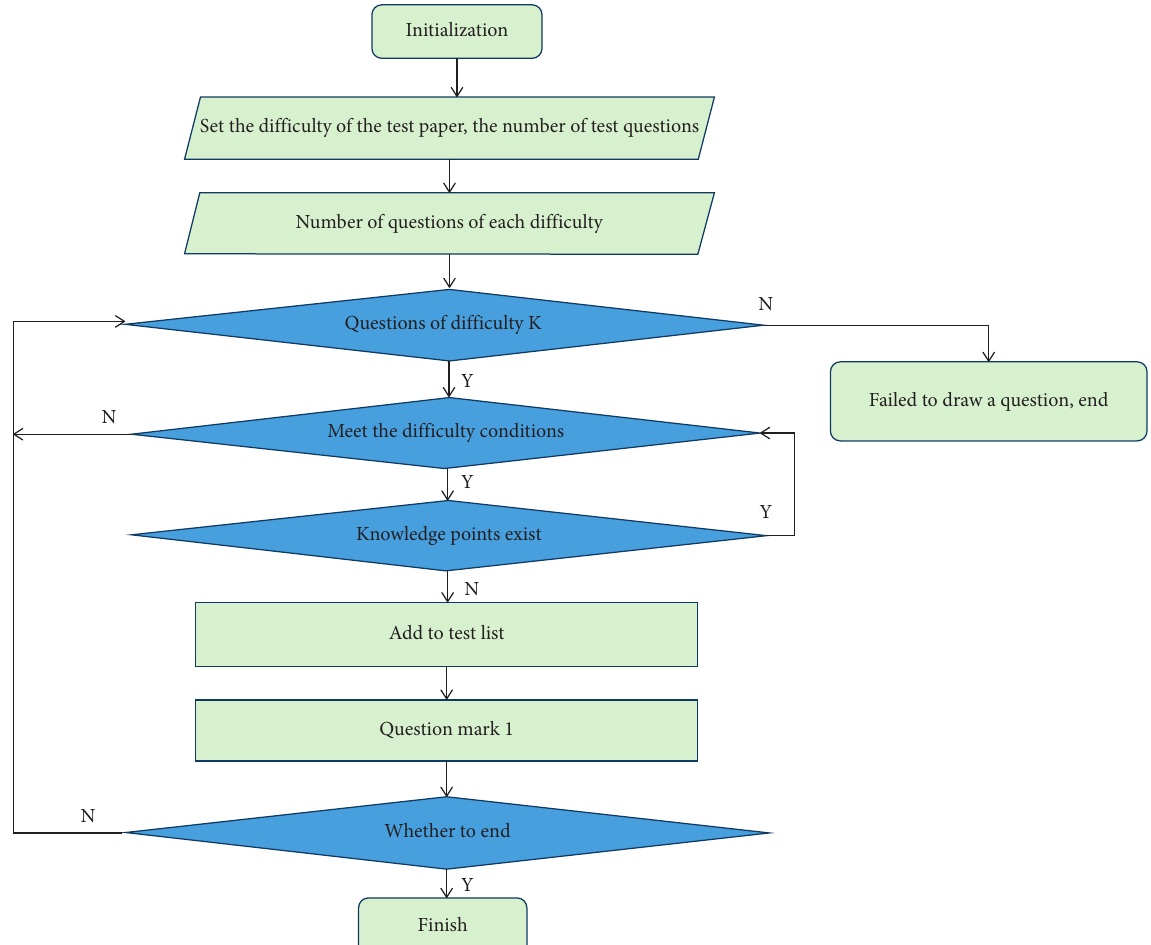
Figure 3: The flow of the random grouping